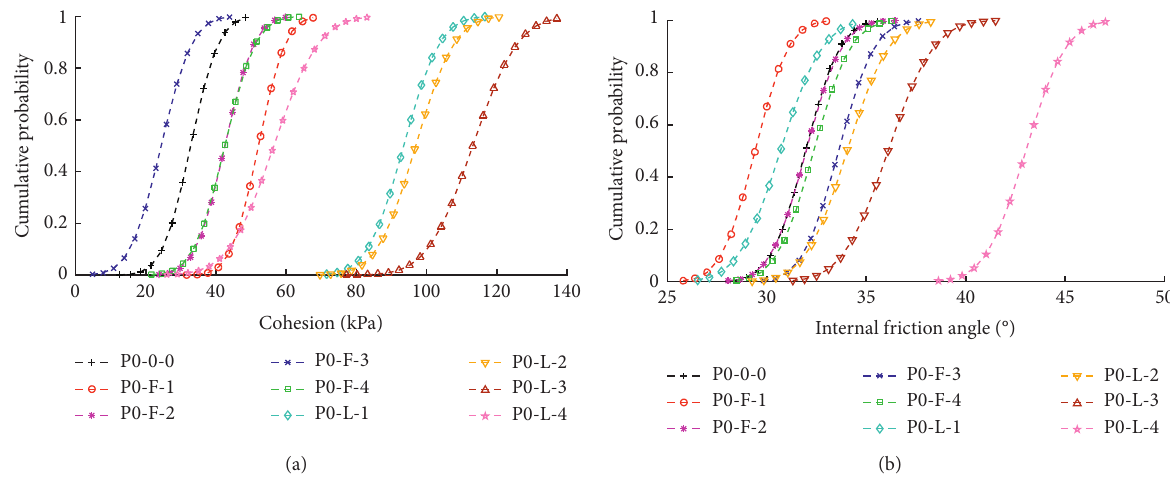
Figure 5: Cumulative probability distribution of the c and φ of the modified iron tailings with the 0 freeze and thaw cycle: (a) a cumulative distribution image of the cohesion c in different proportions and (b) a cumulative distribution image of the internal friction angle φ